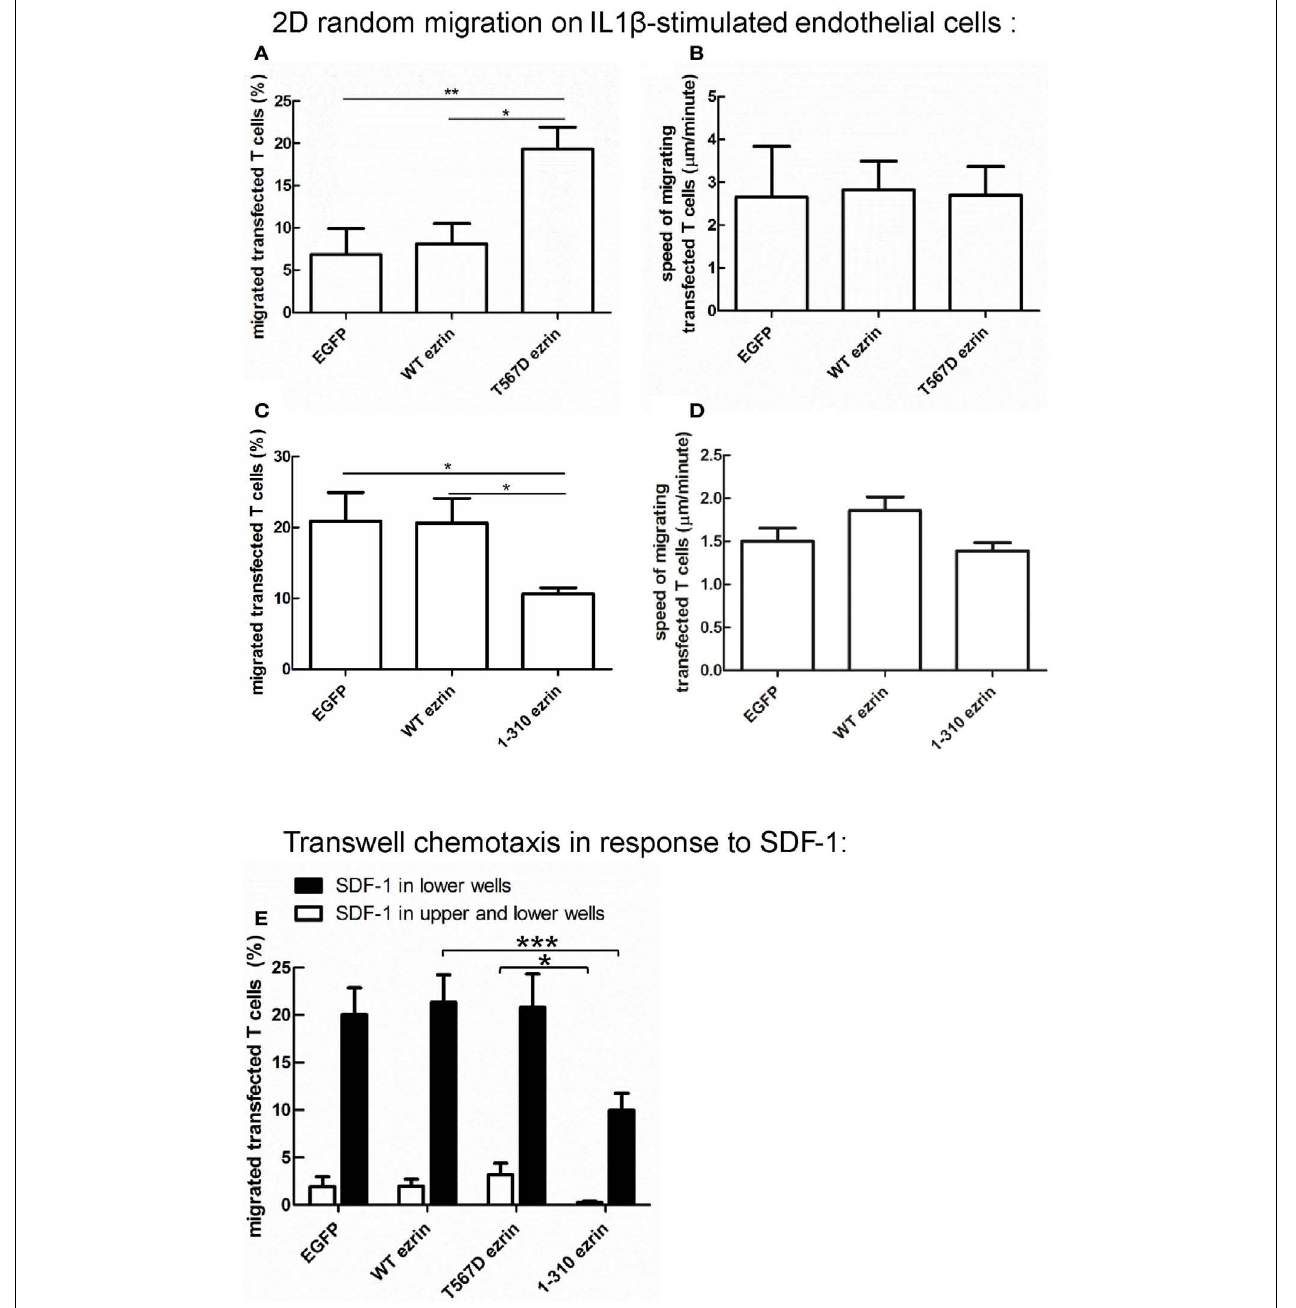
wild type ezrin; 437 cells transfected withT567D ezrin; 679 cells transfected with 1–310 ezrin). (E) T cells were transfected with the indicated constructs and placed 4h later into filter inserts.The lower and upper wells (open bars) or only the lower wells (closed bars) contained 200ng/ml SDF-1.The number of transfected migratedT cells in the lower wells was determined after 1h and calculated as % of total transfectedT cells placed initially into the upper wells. In the absence of SDF-1 in the lower wells migration was zero for all samples and experiments. Mean ± SEM of eight experiments for SDF-1 only in the lower wells and of three experiments for SDF-1 in the upper and lower wells. * P < 0.05, *** P < 0.001 for statistically significant differences between data as